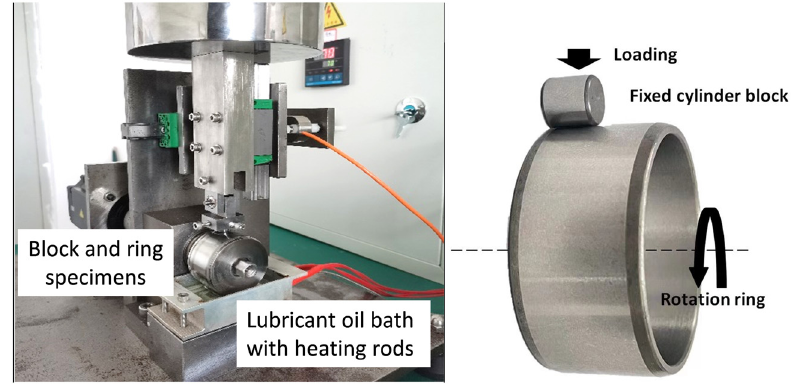
Figure 2: The con fi guration of the block - on - ring test and the testing